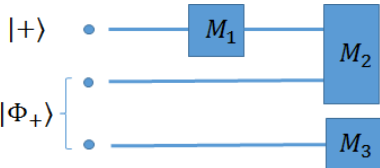
Figure 5 . Measurement scheme to probe \clones". The measurement M 1 has projectors P 0 = j 0 ih 0 j ; P 1 = j 1 ih 1 j , and prepares j 0 i or j 1 i respectively with outcomes 0 ; 1. M 2 is a